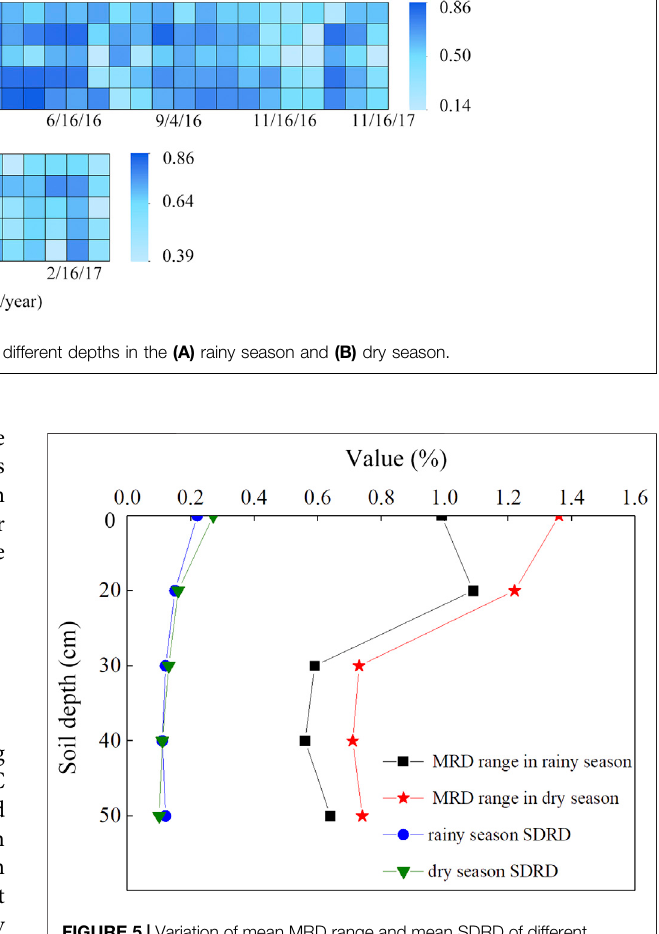
FIGURE 5 | Variation of mean MRD range and mean SDRD of different soil layers change with depth in the rainy season and dry